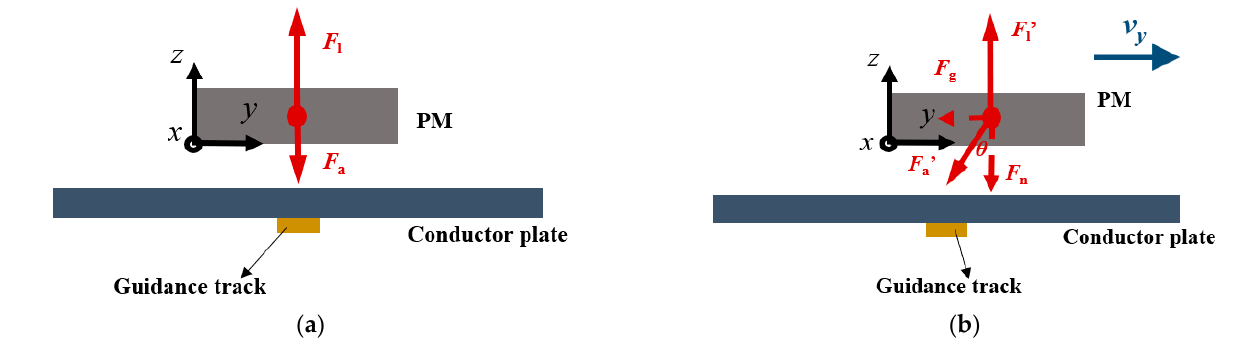
Figure 2. Guidance force analysis under different conditions: ( a ) PM and track are in alignment; ( b ) The vehicle exists in transverse displacement.